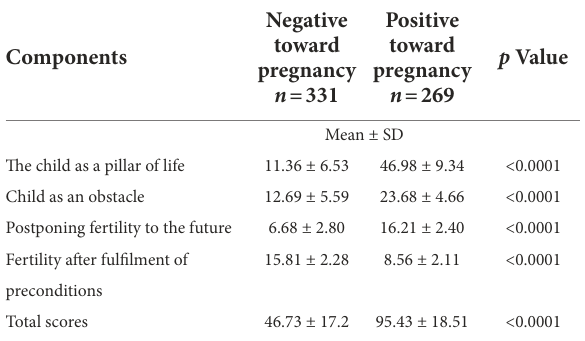
TABLE 2 Comparison of scores of fertility decision among two groups with positive and negative attitudes toward pregnancy and childbearing during the COVID-19 pandemic.